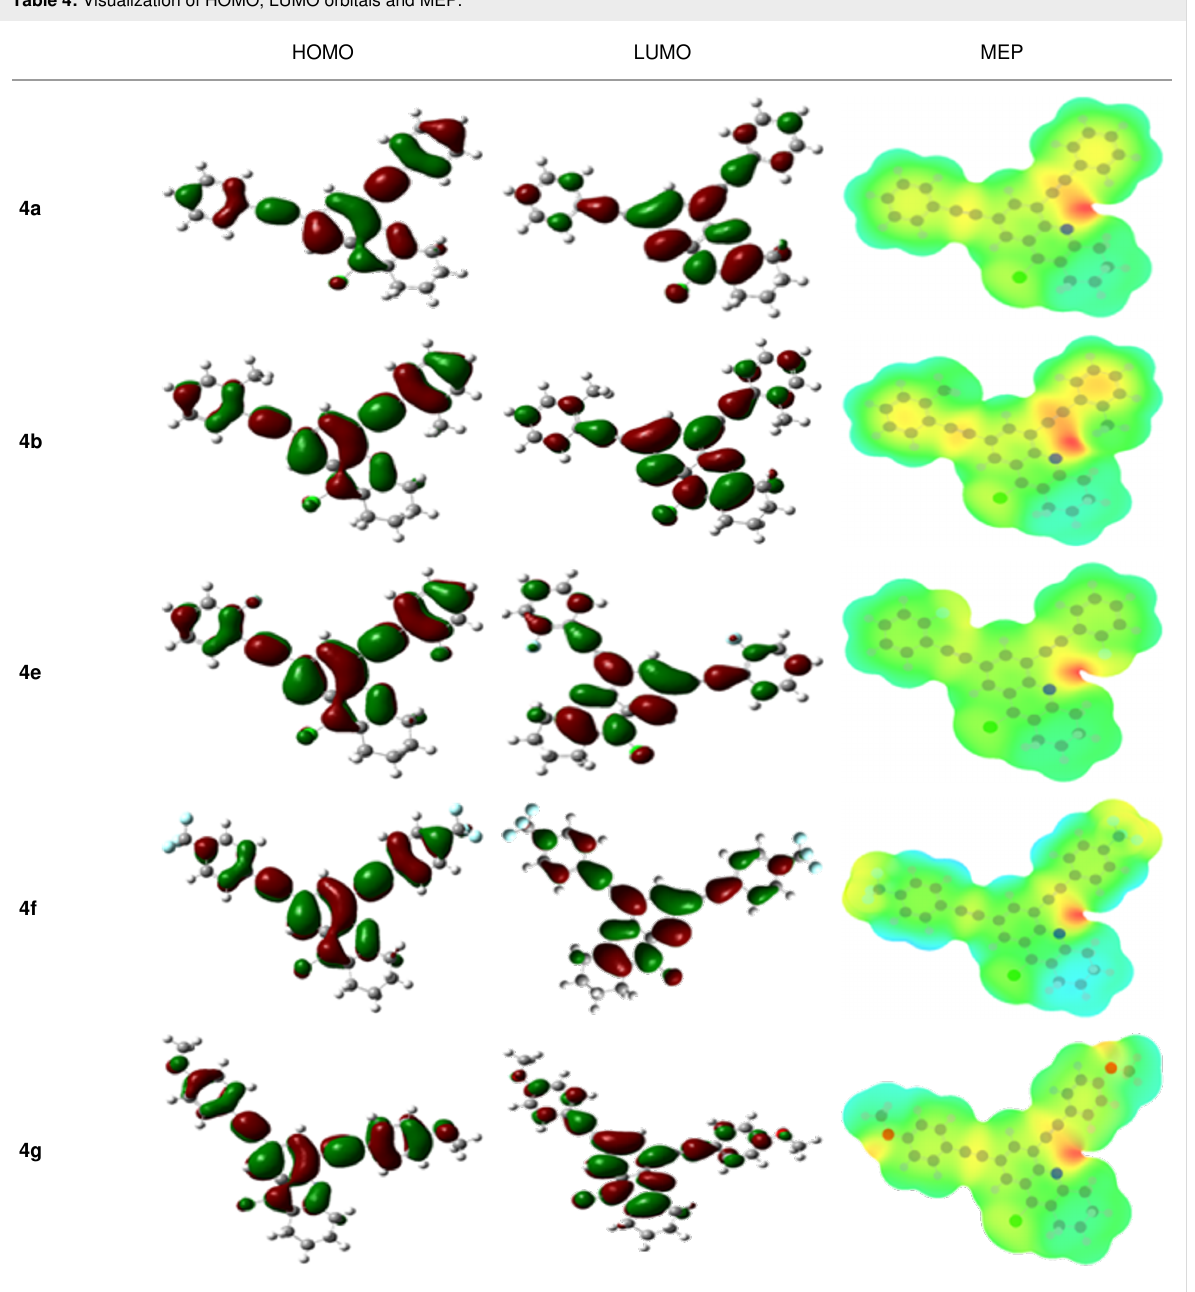
Table 4: Visualization of HOMO, LUMO orbitals and